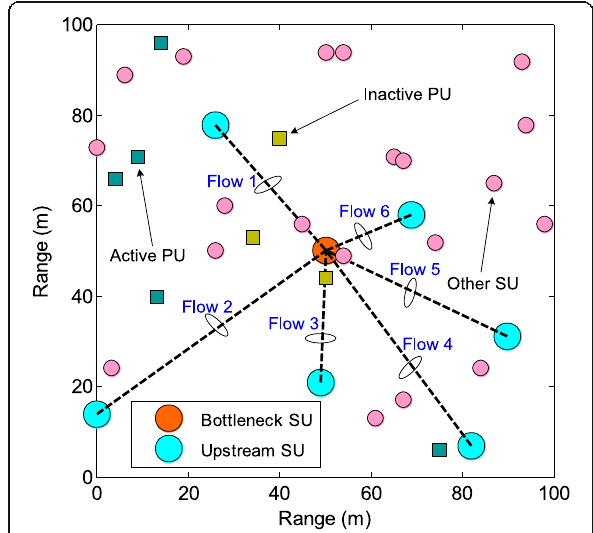
Fig. 5 Simulation scenario: N = 6 upstream SUs transmitting data packets with elastic traffic towards bottleneck SU within a range of 100 m × 100 m. The dotted lines correspond to the successful transmission links from upstream SUs to bottleneck